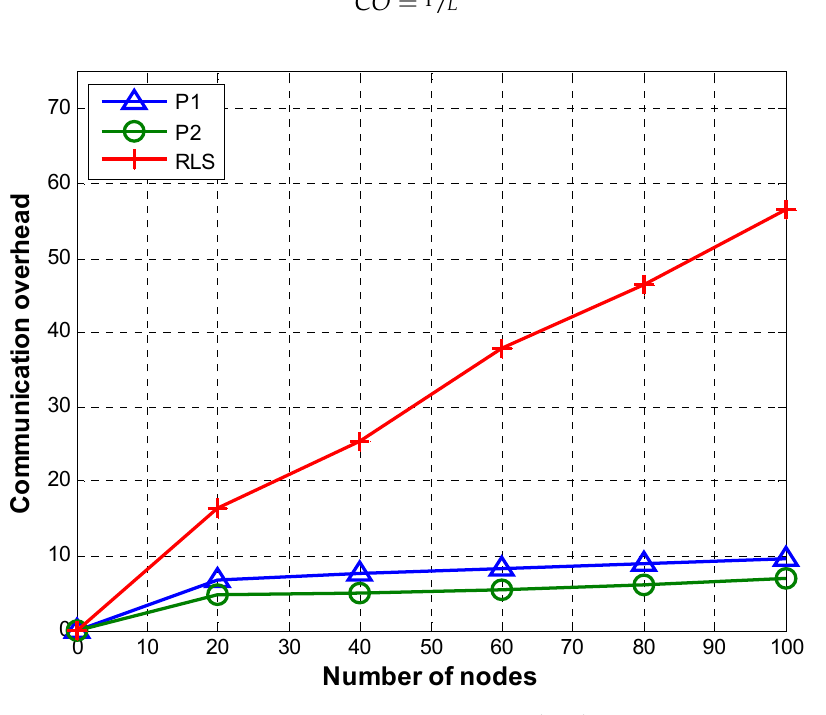
Figure 11. Communication overhead.